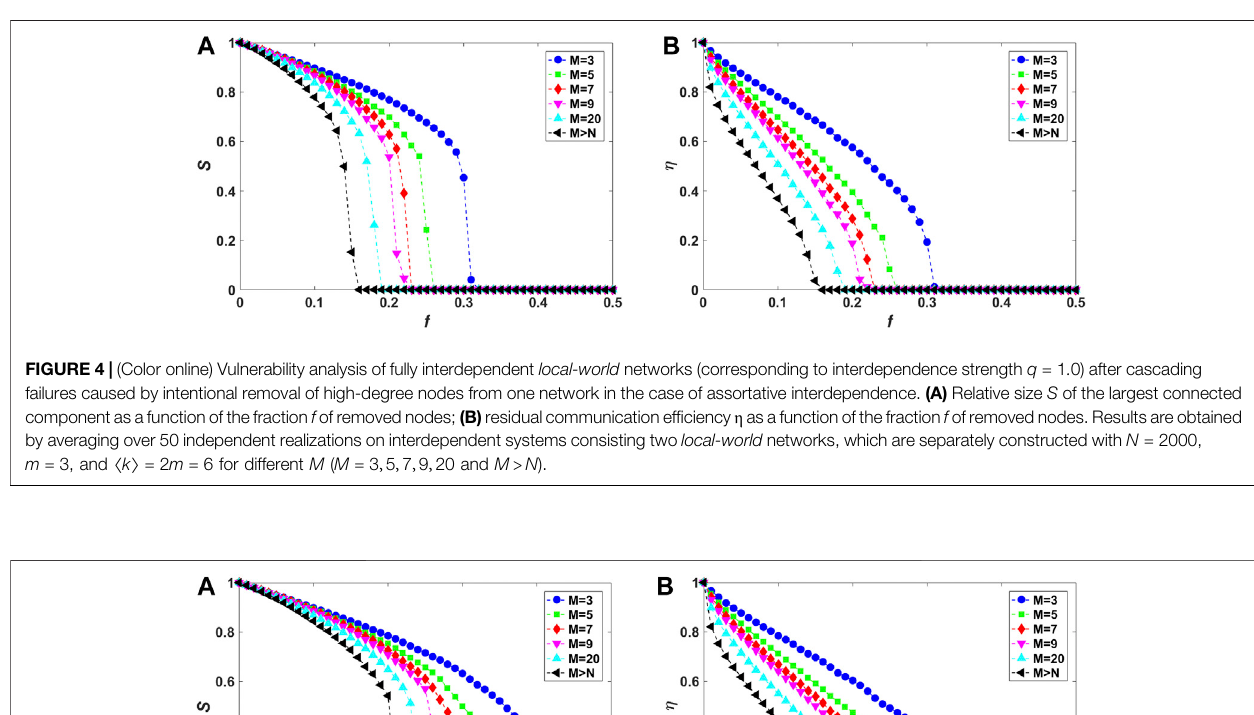
interdependence ( Figure 5A ), respectively. The same phenomena can be observed in networks with M (cid:2) m (curves with solid random coupling and disassortative cases are f c ≈ 0 . 35 and f c ≈ 0 . 40, respectively.